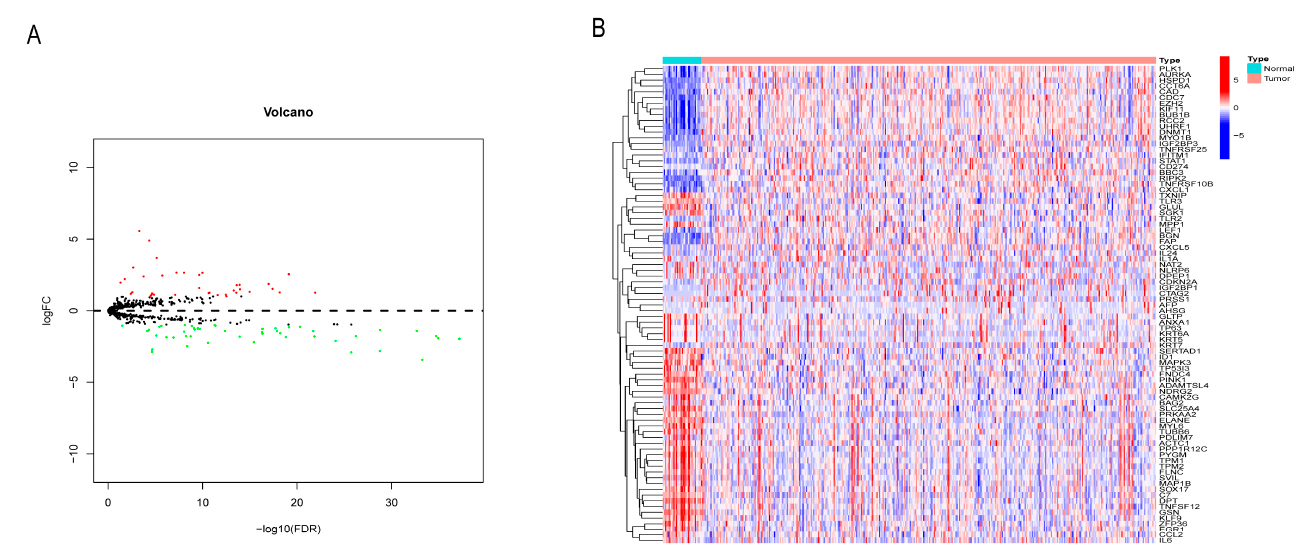
Figure 2. Expression analysis of NRGs in GC. ( A ) Volcano map (red dots represent up-regulated genes, green dots represent down-regulated genes and black dots represent the genes with no difference).